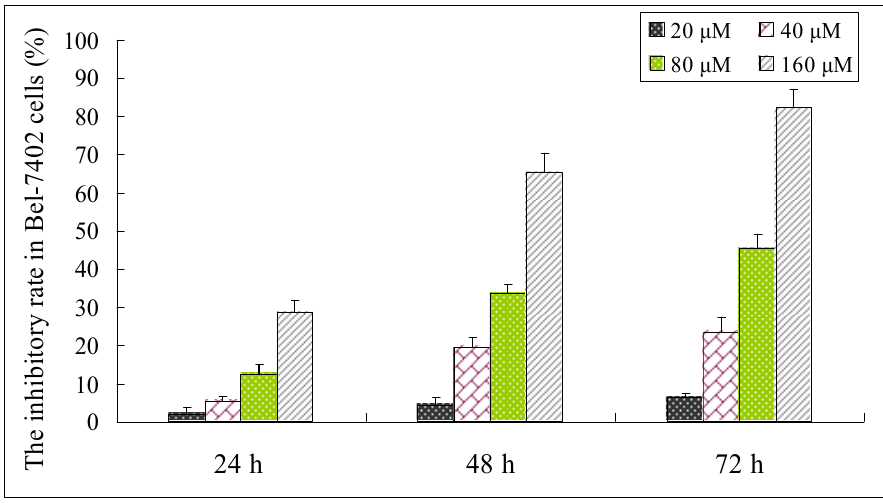
Figure 2. The inhibitory rate of human hepatoma carcinoma cells (Bel-7402) after being treated with compound 1 at different concentrations (20, 40, 80, 160 μ M) for 24 h, 48 h and 72 h, respectively. Date were shown as means ± S.D. (n = 6). The data are represented as mean ± S.D for six independent